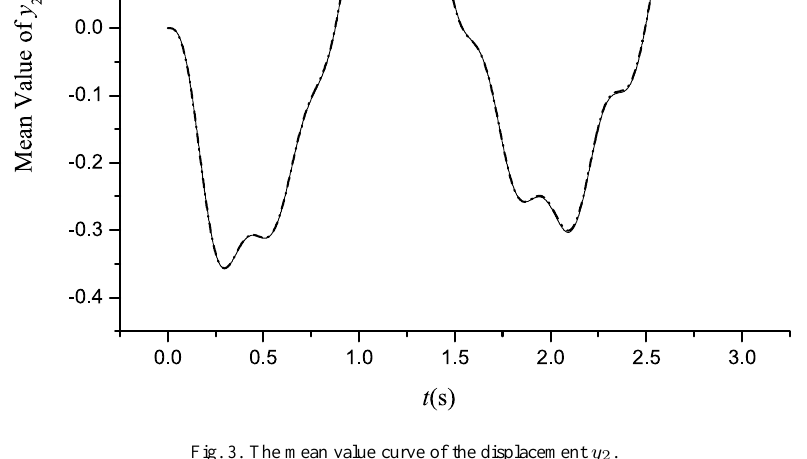
Fig. 3. The mean value curve of the displacement y 2 .